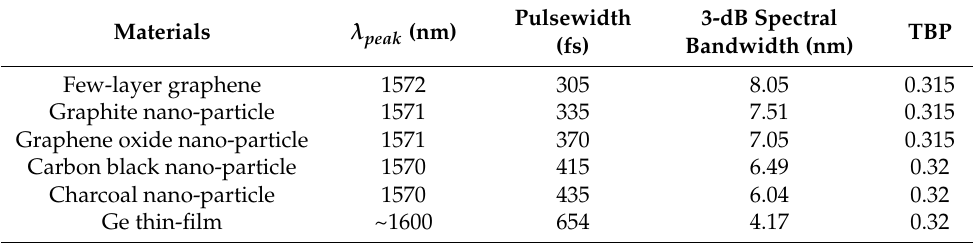
Charcoal nano-particle